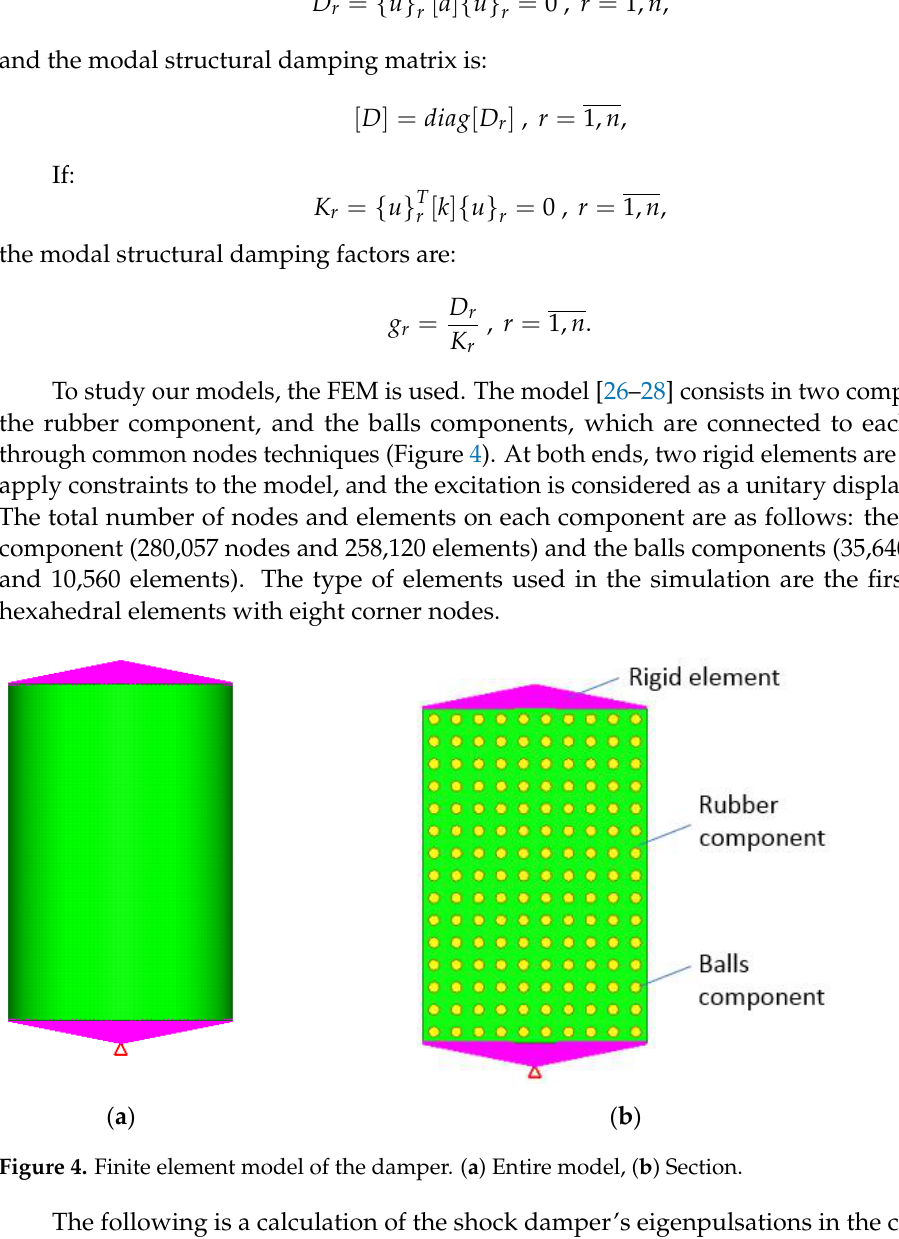
Table 3. The eigenpulsations for three different cases (N = 1320).